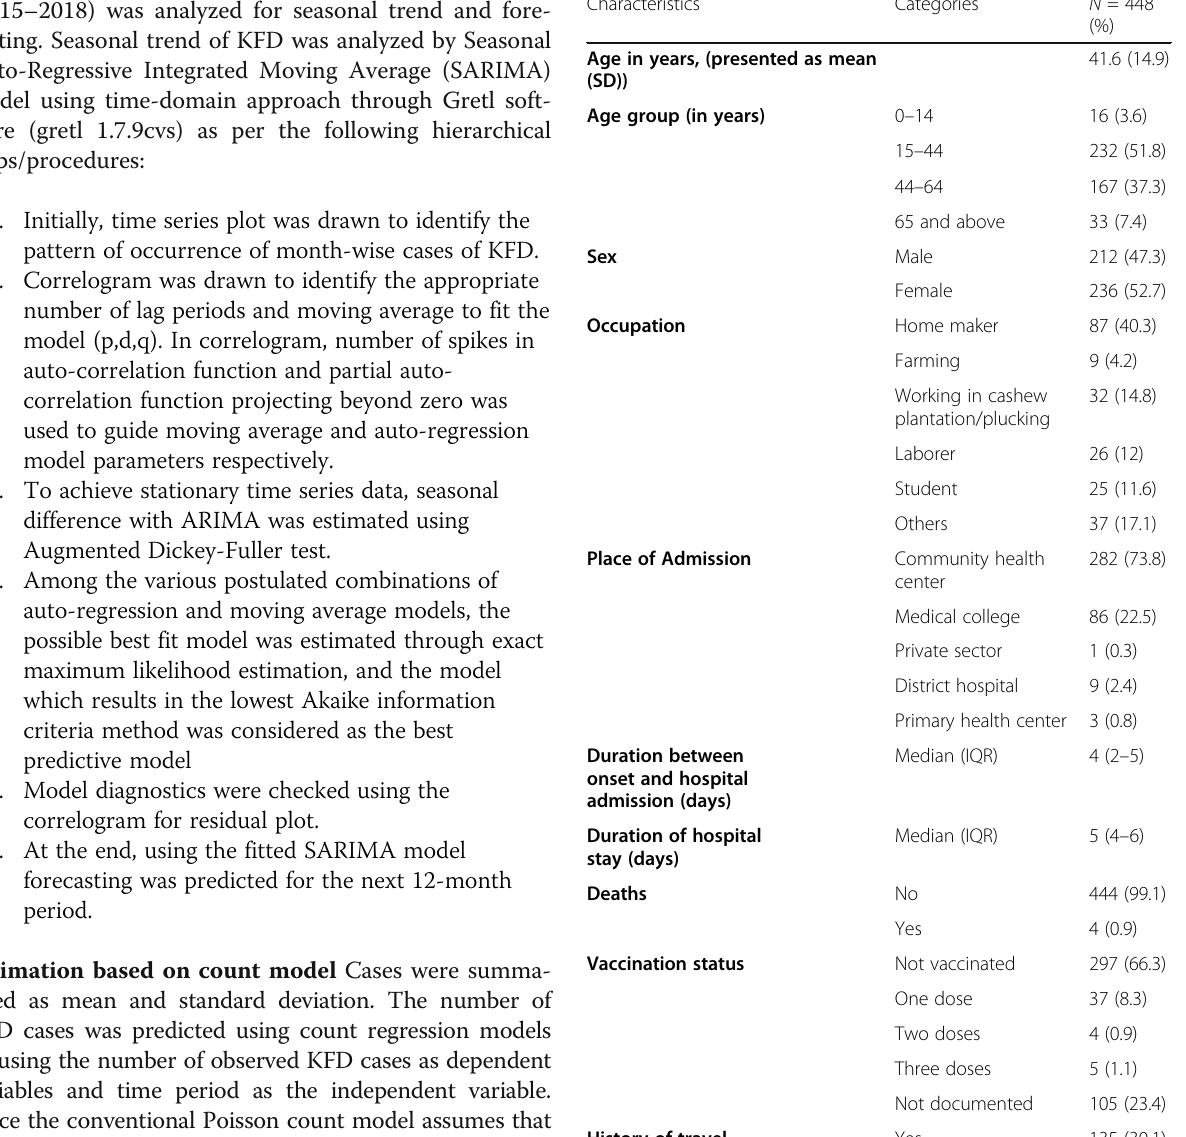
Table 1 Demographic and clinical characteristics of